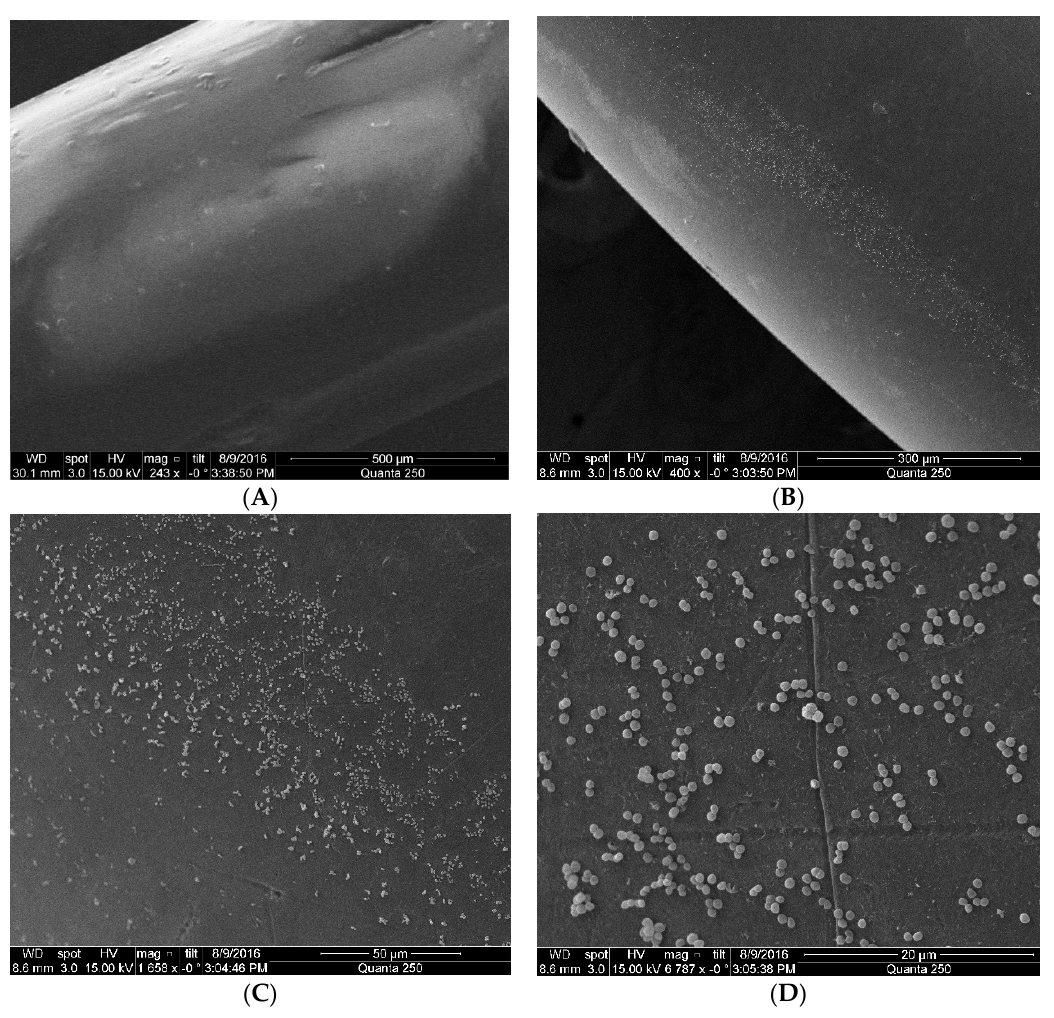
Figure 9. Four pictures with different magnification taken from the sensors under the electron scanning microscope. In ( A ) the picture shows the reference U-Shaped sensor without functionalization under a scale of 500 µm. In ( B ) the U-Shaped sensor functionalized in a suspension of 10 8 CFU/mL of Escherichia coli with a scale of 300 µm. The small dot are the adhered bacteria. ( C ) Bacteria seen at the sensor surface under a scale of 50 µm. ( D ) Under a scale of 20 µm, it is possible to notice individual bacteria distributed along the sensor surface. Each bacterium measures about 2 µm in length by 1 µm in diameter.